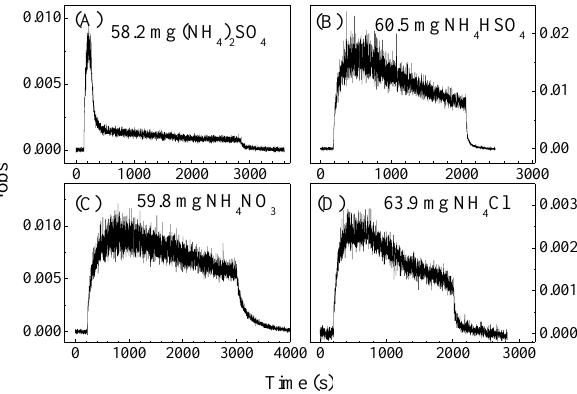
Fig. 4. Typical observed uptake coefficients of MA onto ammonium salts at 298 K. 659